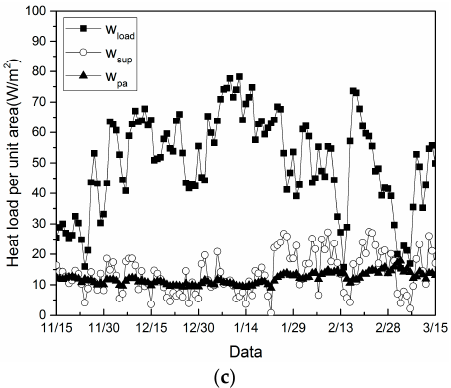
Figure 6. Daily average active ( a ), passive solar ( b ) energy saving rate and the actual values for w sup , w pa , and w load ( c ) during heating season.